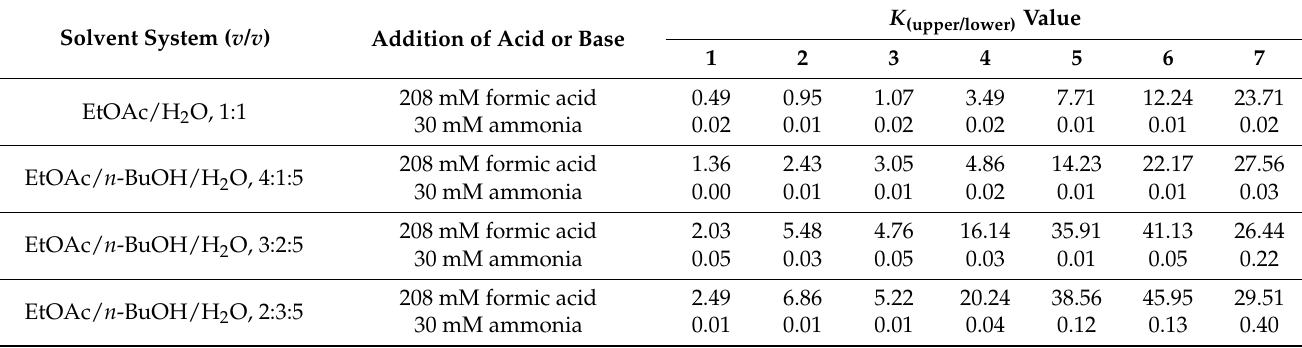
Table 2. Partition coefficients ( K upper/lower ) of target compounds 1–7 in different biphasic solvent systems under acidic or basic